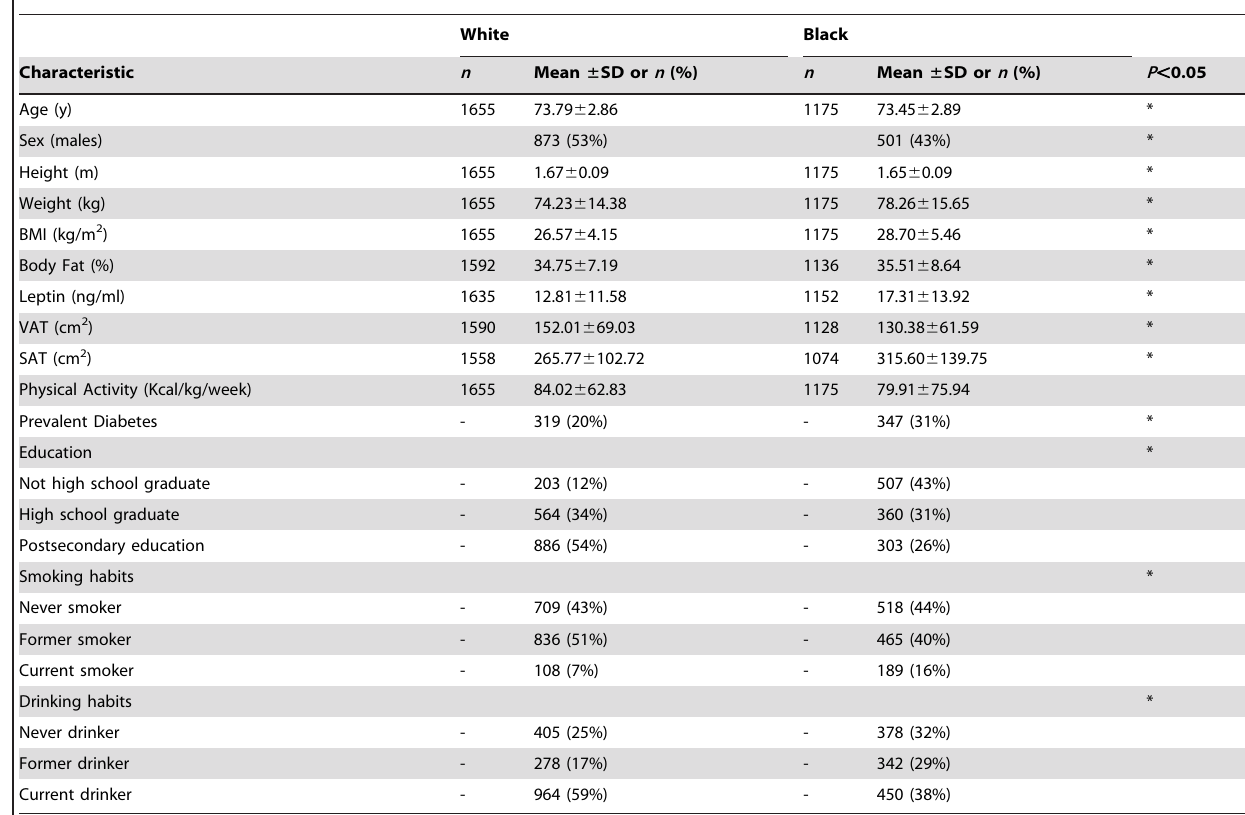
Table 1. Health ABC participant characteristics by race.